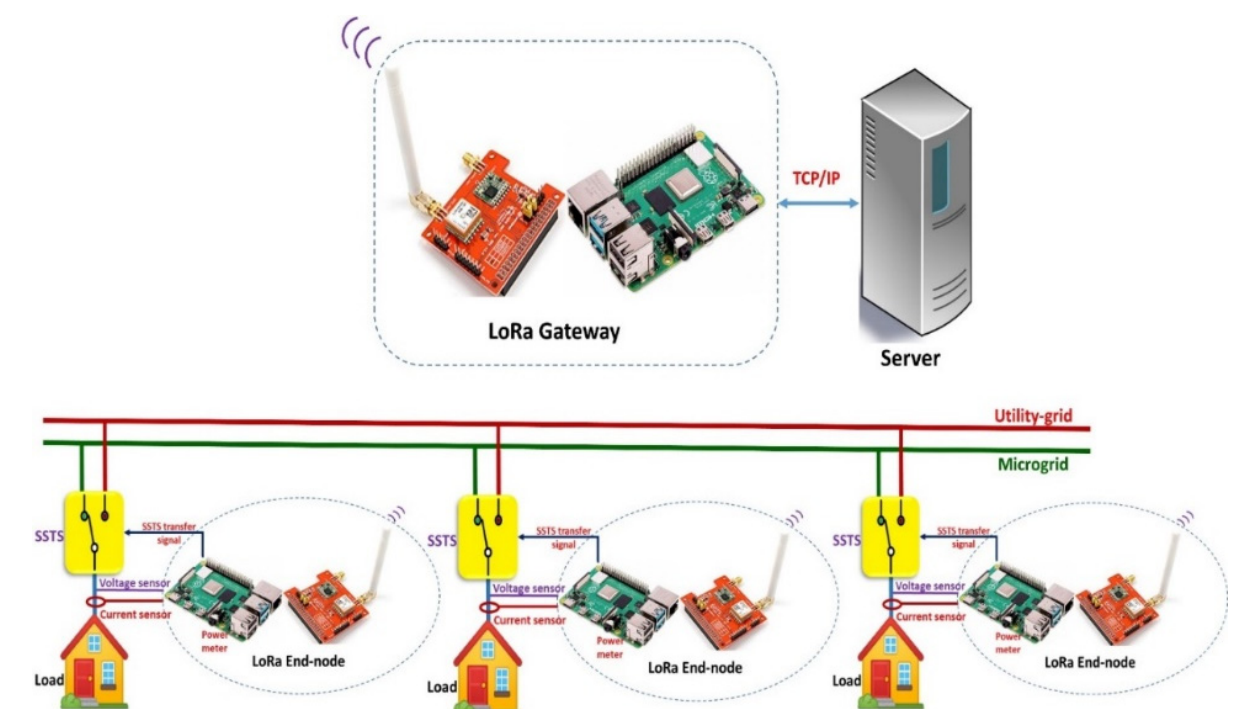
Figure 14. Representation of IoT LoRa-based communication network within proposed microgrid design.